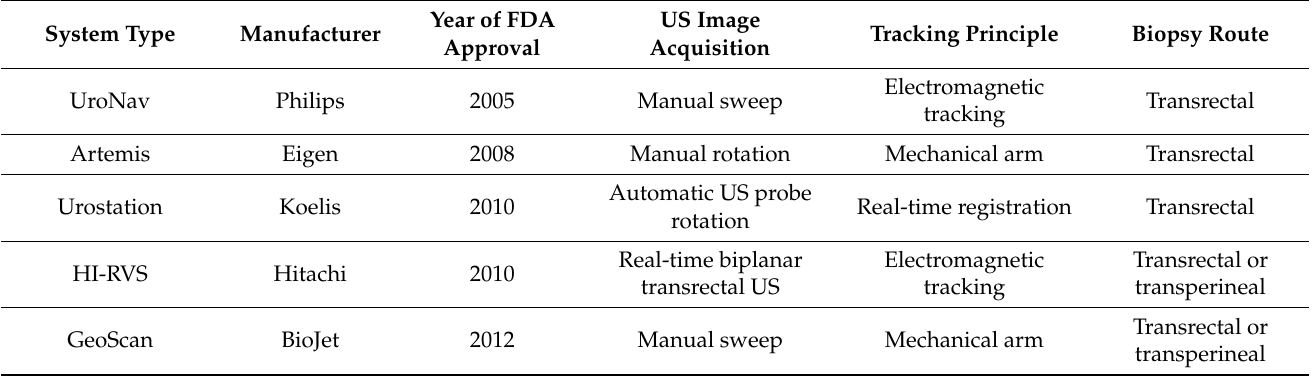
Table 5. U.S. Food and Drug Administration approved US/MRI fusion system